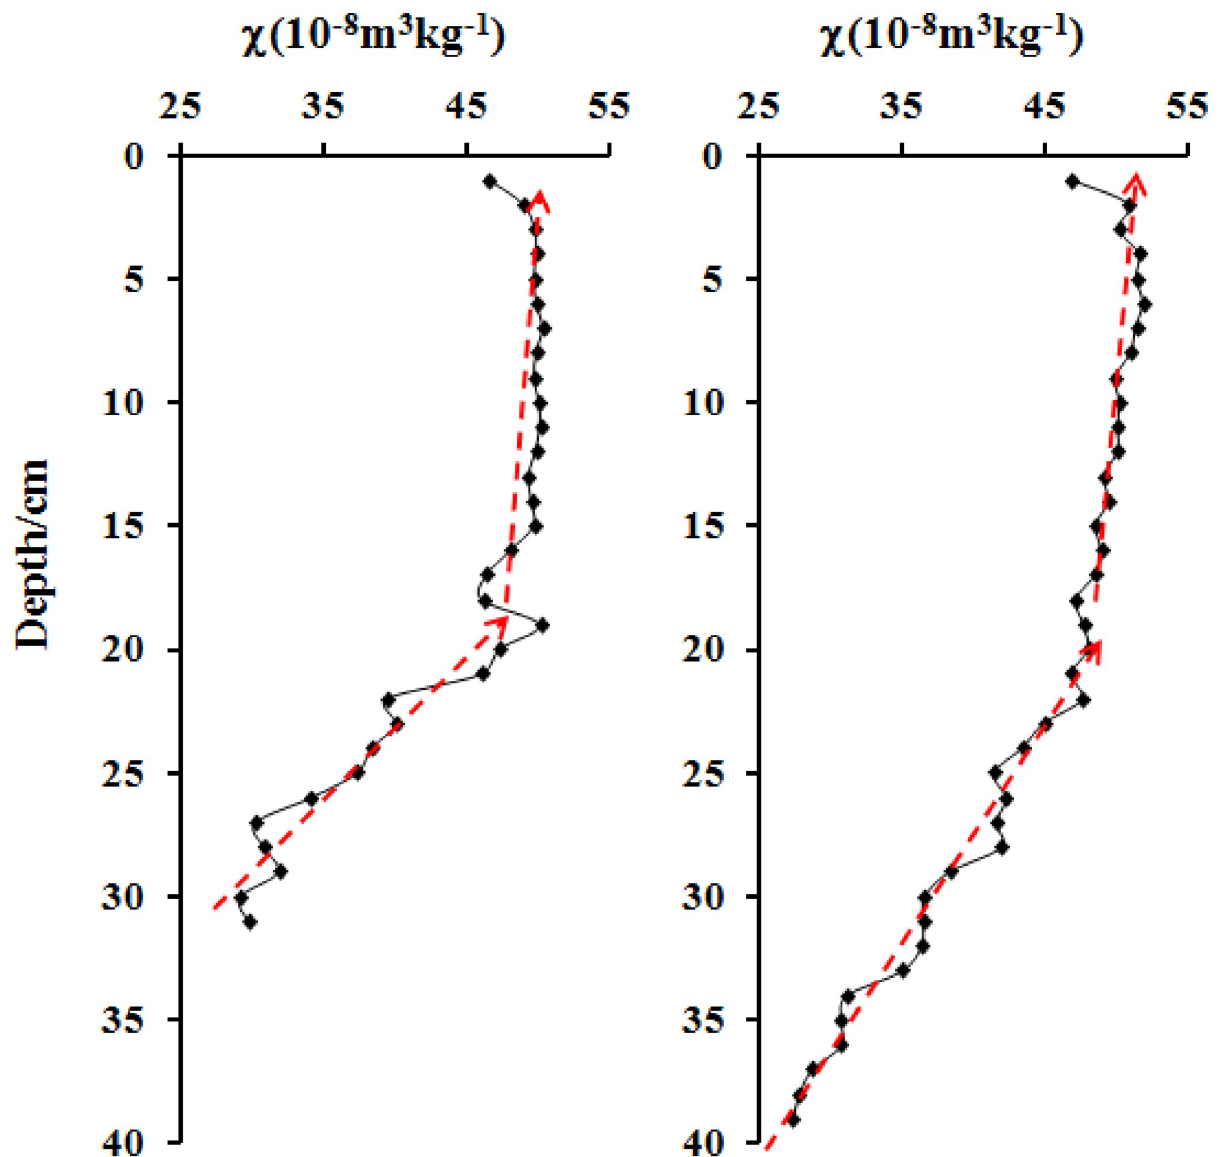
Fig 1. Magnetic susceptibility variation of cores QH1 (left) and QH2